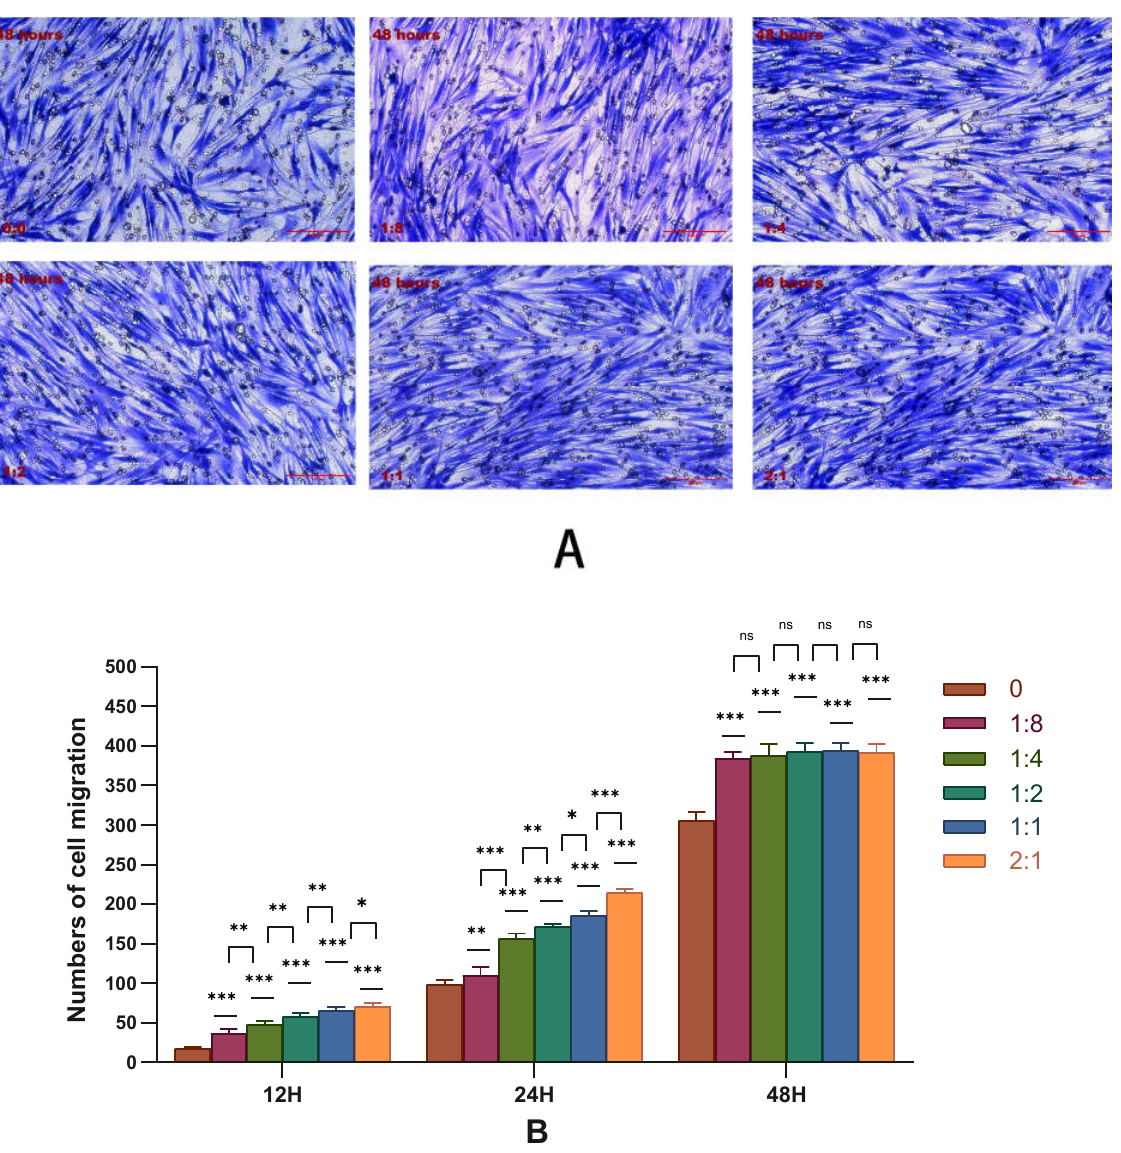
Figure 2. Migration of HSFs after 12 h, 24 h, and 48 h co-culture. ( A ) The crystal violet staining map of HSFs after migrating through Transwell chamber. ( B ) The statistical chart of fine migration of fibers. ns: p > 0.05, *: p < 0.05, **: p < 0.01, ***: p < 0.001. Scale bar: 100 μm.